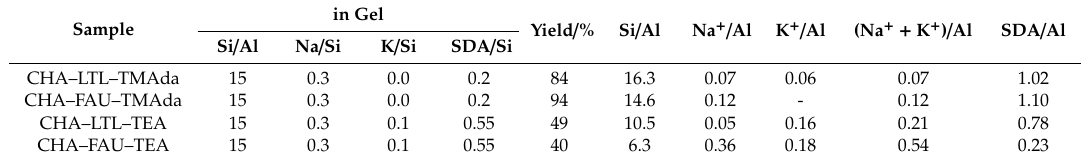
Table 1. Physicochemical properties of the as-made